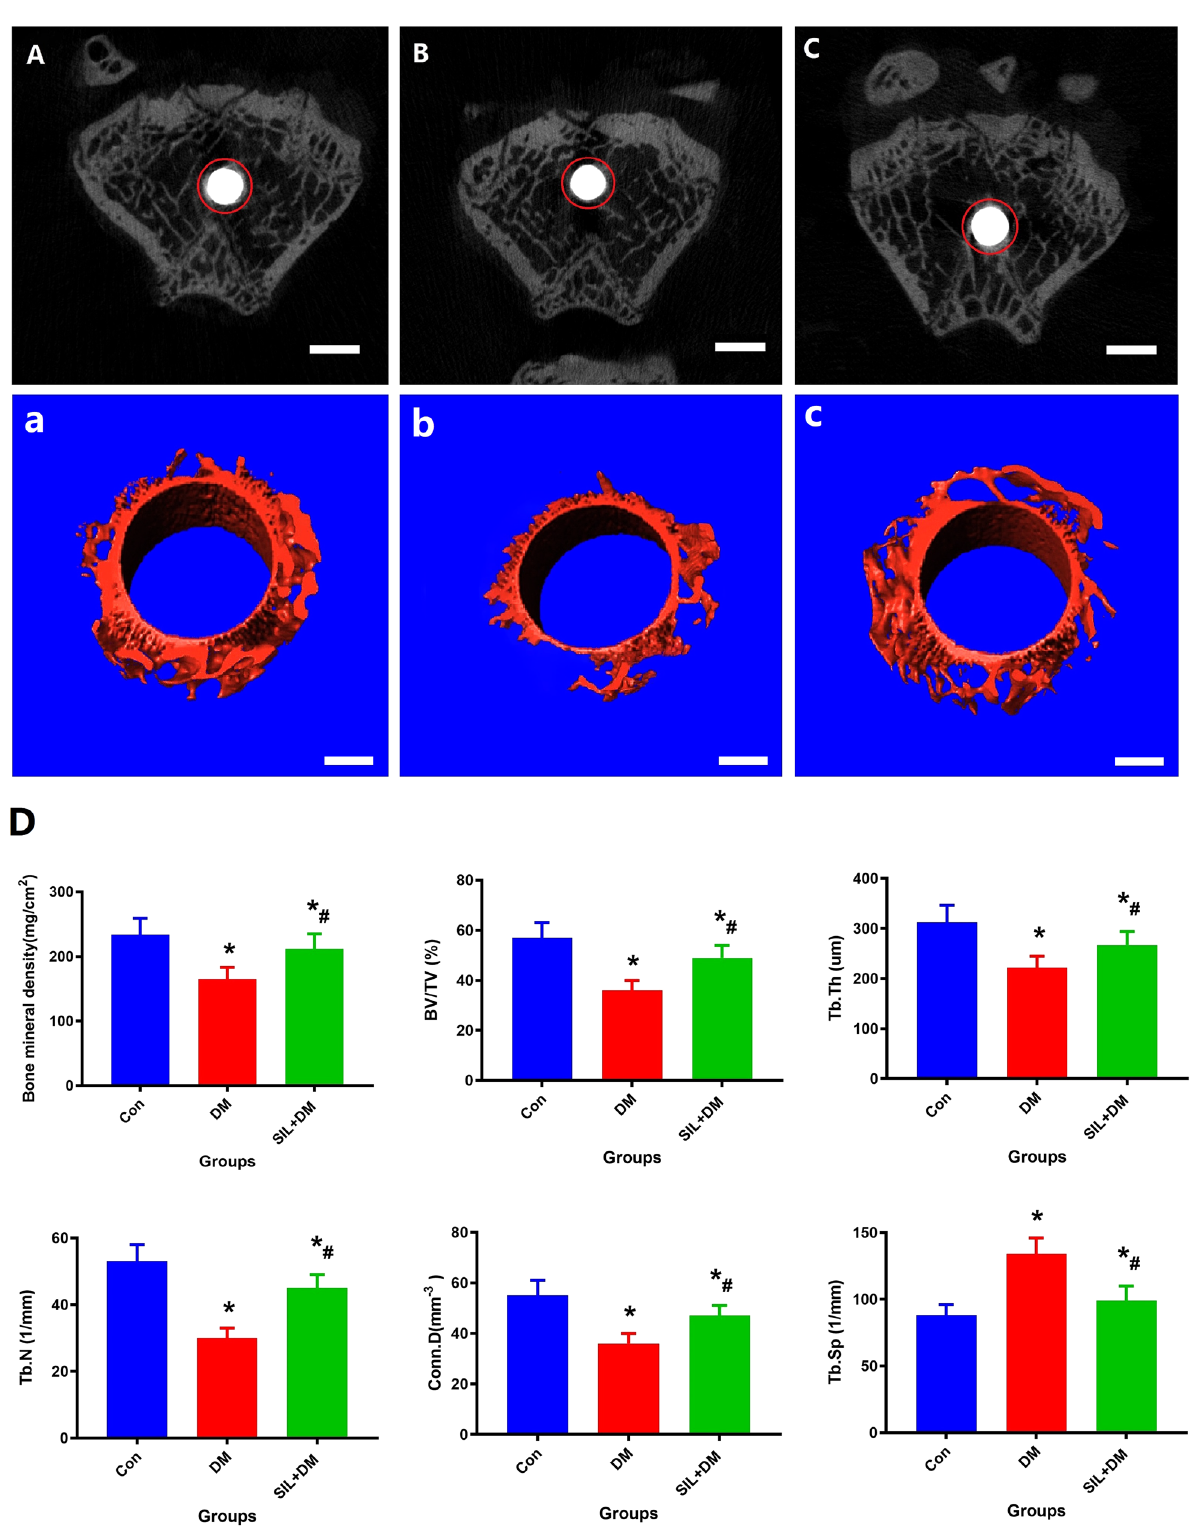
Fig. 4 Micro-CT scan and 3D reconstruction clearly shows that local administrator SIL can signi fi cantly restore the poor capacity for tita- nium rods osseointegration in diabetic rats. A , a: Con group; B , b: MD group; C , c: SIL + DM group. D : The quantitative results of bone